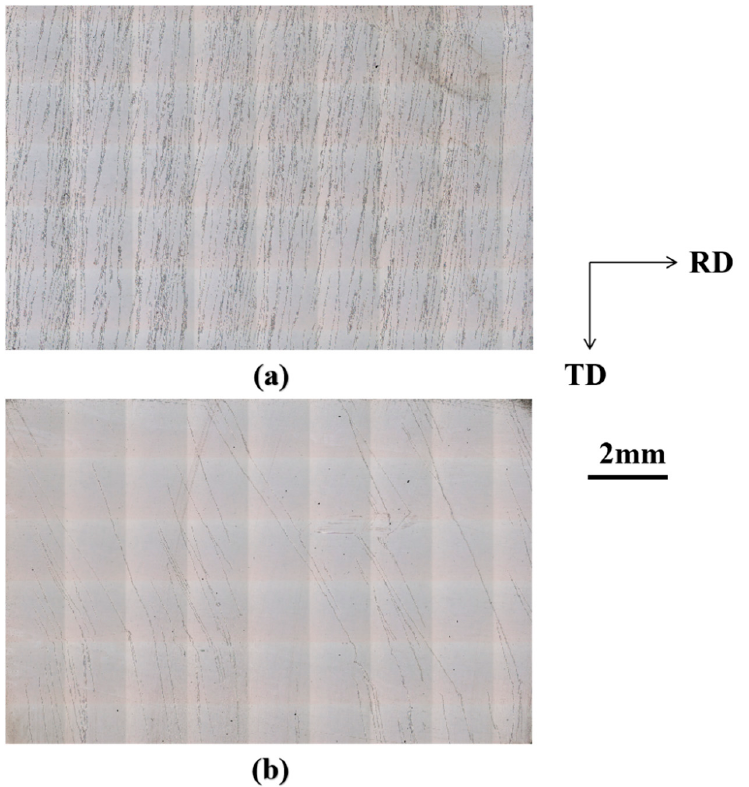
Figure 7. The effect of the deviation degree of the initial Goss orientation on twinning distribution in rolling plane: (a) 3° deviated Goss oriented grain; (b) 10° deviated Goss oriented grain.